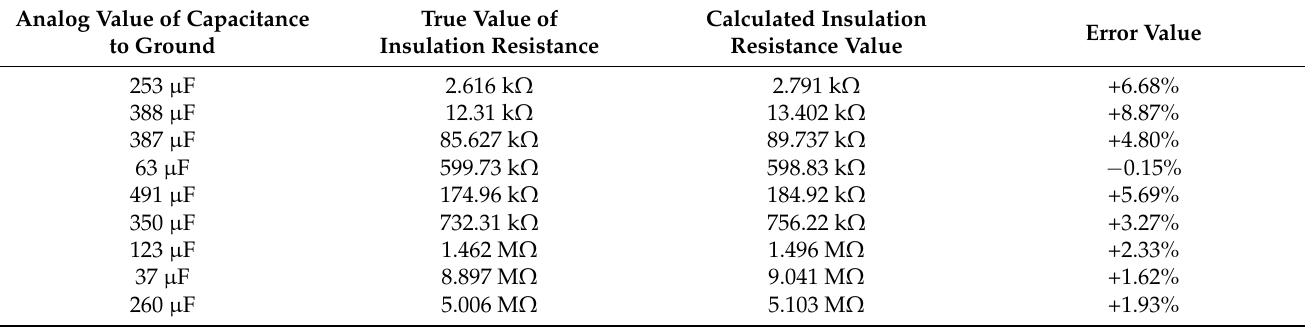
Table 2. Experimental